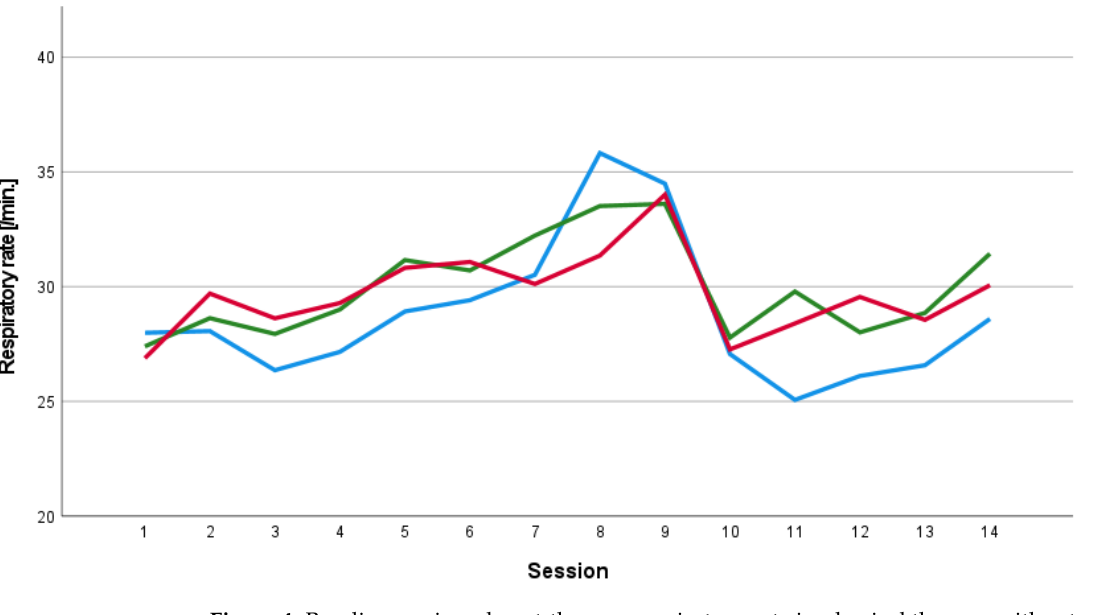
Figure 4. Baseline, peri- and post-therapy respiratory rate in physical therapy without music ther- apy. Blue line: mean baseline value, green line: mean peri-therapy value, red line: mean post-therapy value.